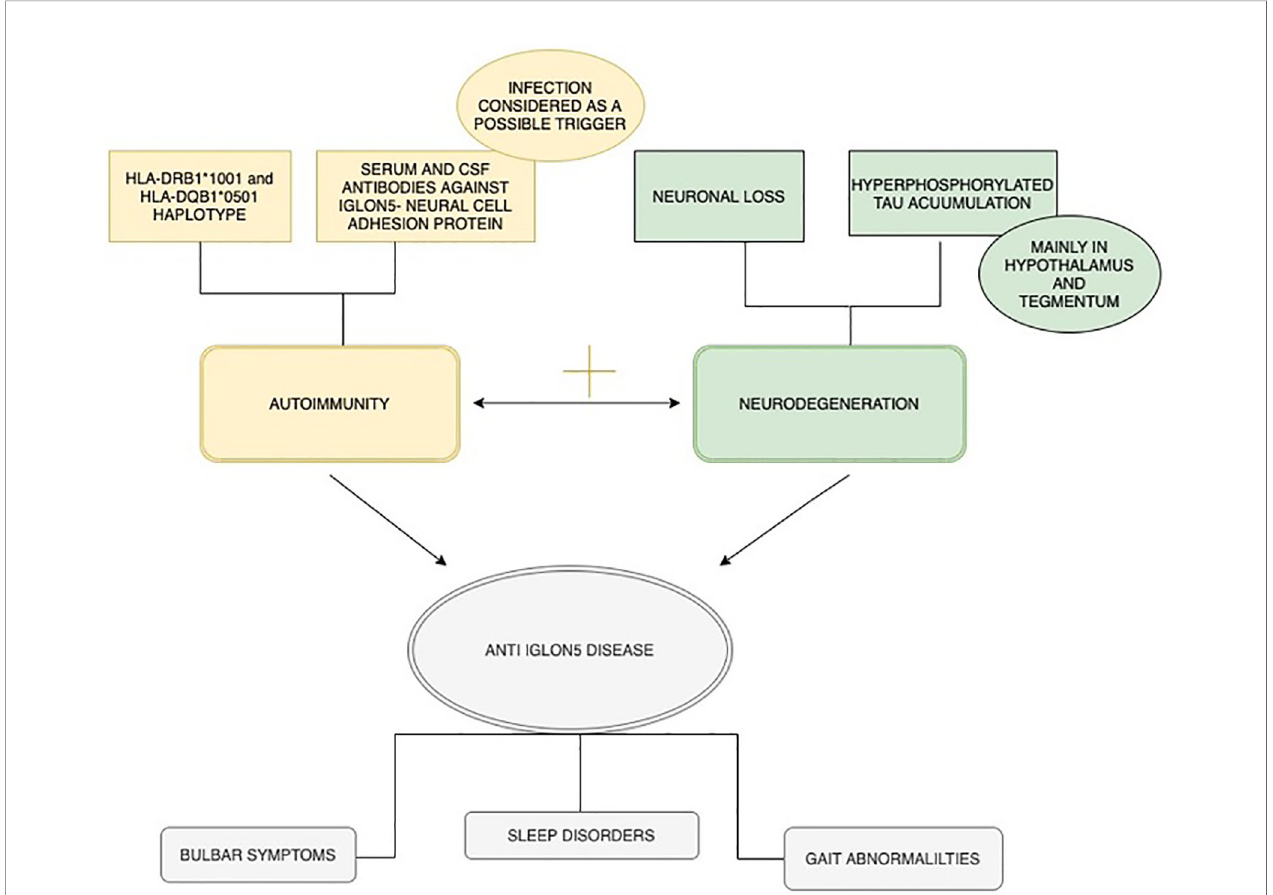
FIGURE 1 | Possible heterogenous mechanism of anti-IgLON5